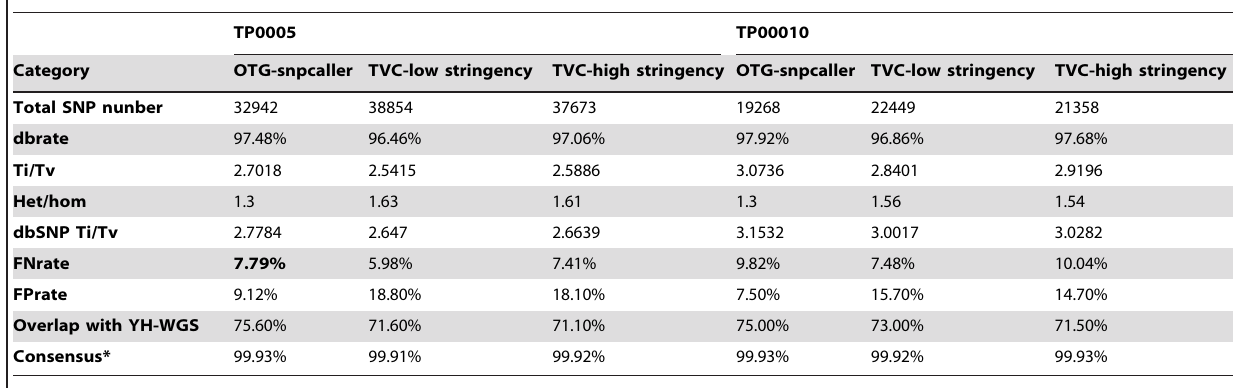
Table 3. Comparison of OTG-snpcaller and TVC.